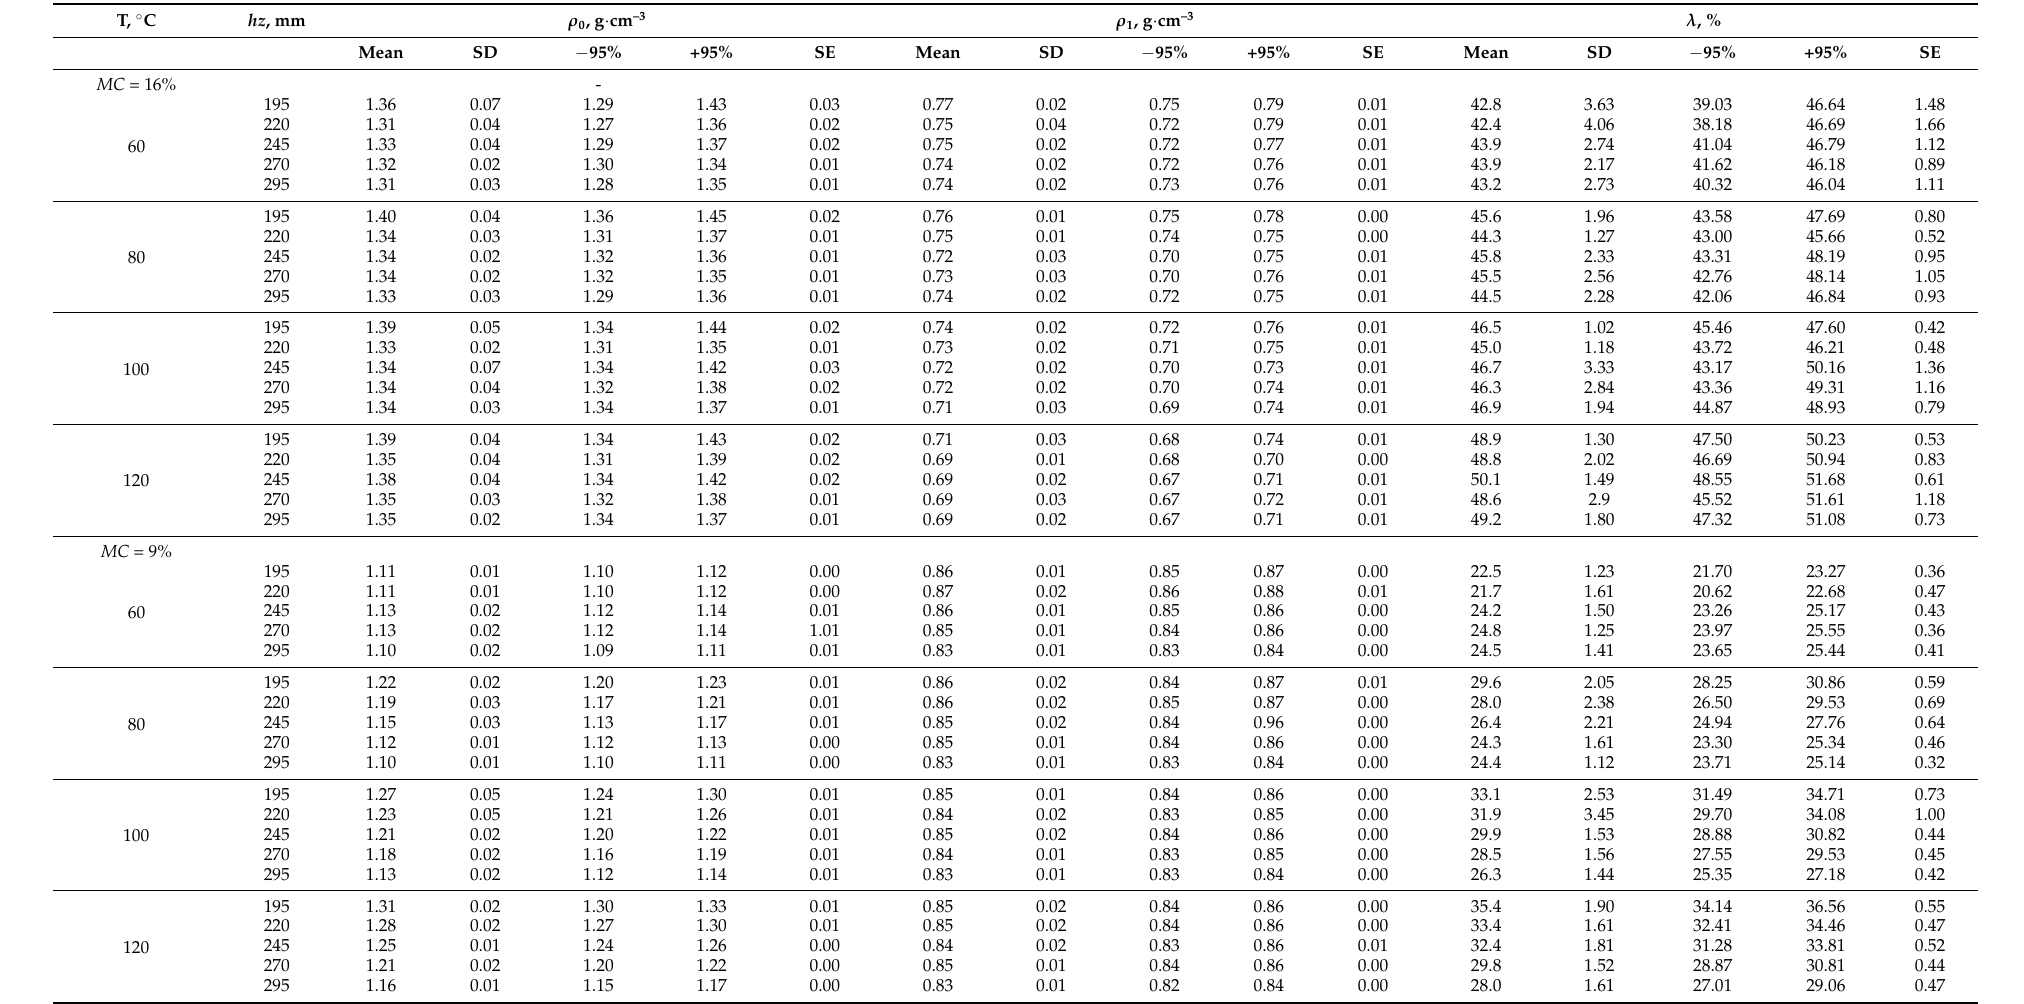
Table 1. The results of changes in briquette